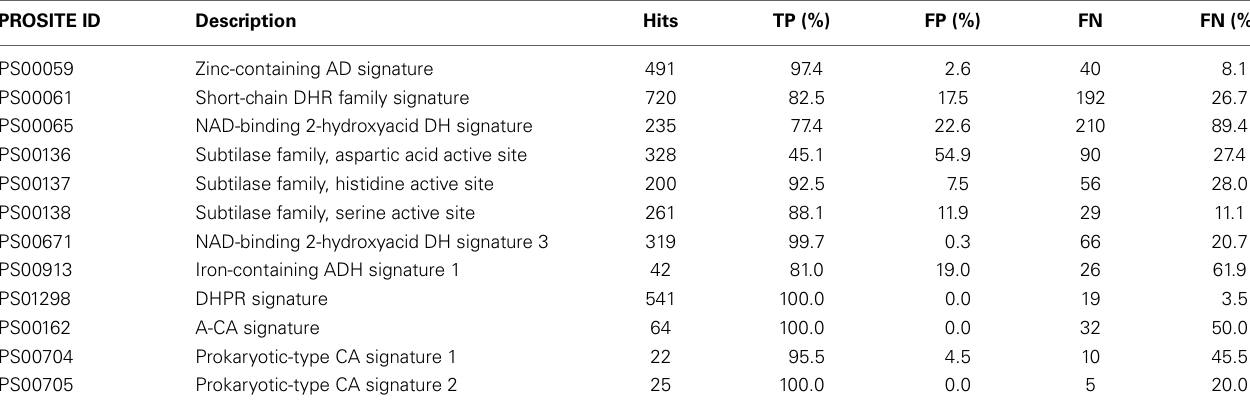
Table 8 | Reliability of consensus patterns found in chosen hits as well as for carbonic anhydrases. PROSITE